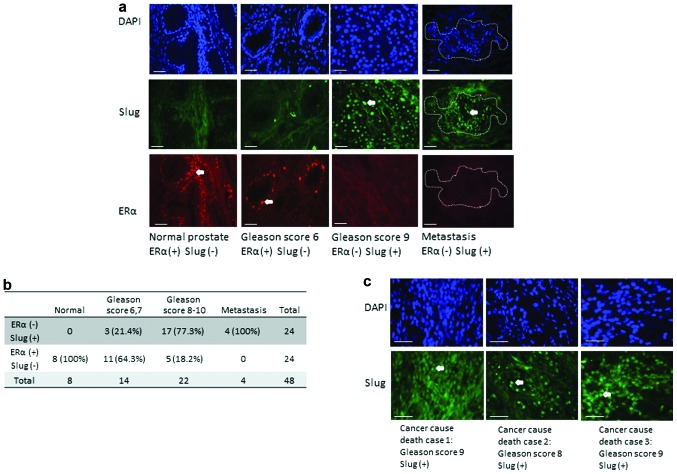
Slug correlates with prostate cancer progression. (a) Representative examples of intense Slug protein expression in prostate cancer tissue microarray (TMA) based on the tissue histologic Gleason score classification and metastasis status. From left to right samples show downregulation of ERα and upregulation of Slug. Staining is recorded on a 2-point scale: (−), negative; (+), positive. The white line indicates the tumor area. White arrow indicates the positive stain. White stars indicate non-specific stain. Scale bar, 50 μm. (b) IF assessment of prostate cancer Slug protein expression from prostate cancer TMA based on prostate cancer histologic Gleason score classification and metastasis status (40 patients). (c) IF staining of 3 cases of cancer-specific death. Scale bar, 50 μm.